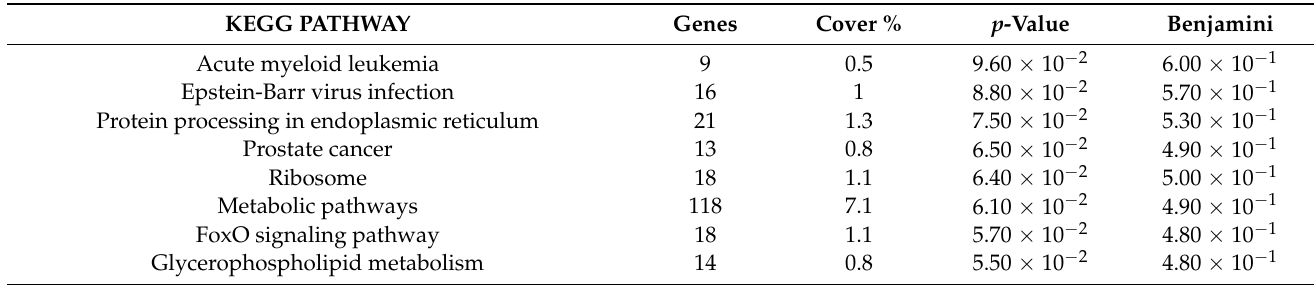
Figure 2. Evaluation of the cell characteristics of ADSCs derived from patients with type II diabetes mellitus. The cell characteristics of normal ADSCs and T2DM ADSCs were evaluated. ( a ) The electron micrographs of the normal ADSC and T2DM ADSC cellular structures, and the difference between the two images was observed. The scale bar indicates 6 µ m. ( b ) The difference in cell growth rate in a 12 h time-course variation of cell count (cells/cm 2 ) is shown. ** p vales = 0.0093 (24 h), * p vales = 0.0354 (36 h), * p vales = 0.019 (48 h). ( c ) The difference in cell death in terms of positive cell rate is shown. The apoptotic marker-positive cells were detected by staining with a fluorescent dye, FITC, using an apoptotic detection kit, and the positive cell rates are shown as the mean ± SE. The number of samples was n = 3. The percentage of apoptosis maker-positive cells was evaluated three times independently. The unpaired t -test was used to test for statistical significance. * p value = 0.0173. The scale bar indicates 20 µ m. Table 1. Listing of KEGG pathways of differentially expressed genes in ADSCs derived from patients with type II diabetes mellitus using a next-generation